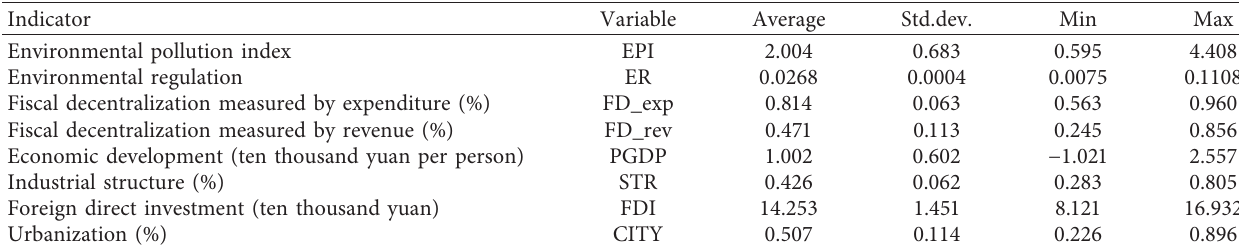
Table 1: Descriptive statistics of variables.